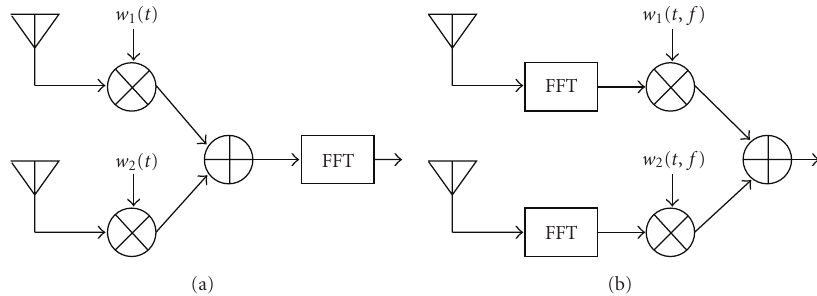
Figure 5: Two diversity combining methods. (a): pre-FFT adaptive array (AA) antenna, (b): post-FFT carrier diversity (CD).